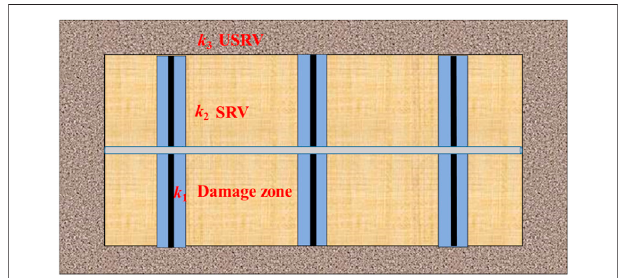
FIGURE 4 | Diagram of reservoir damage permeability.